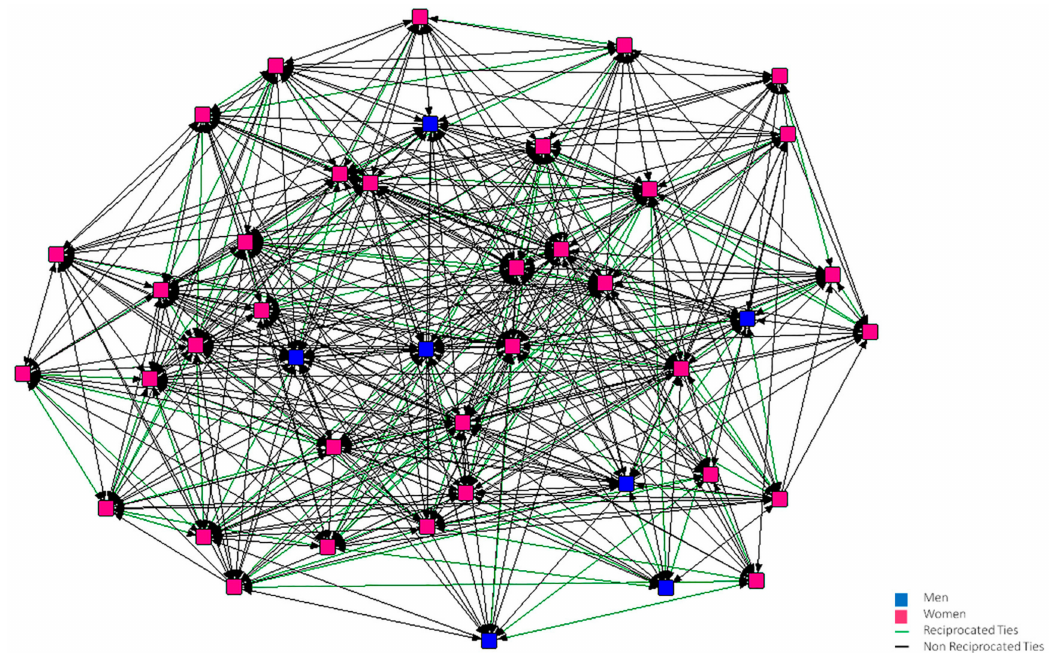
Figure 6. Graph of the third year Minimal Contact